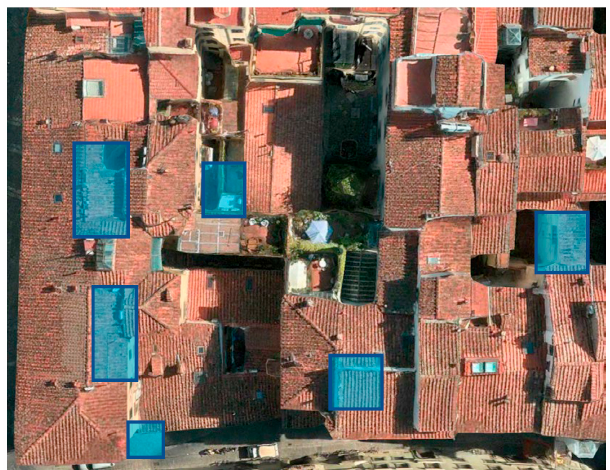
Figure 5. An example of the prospect and roof degradation recognition—blue area: differential deg- radation.